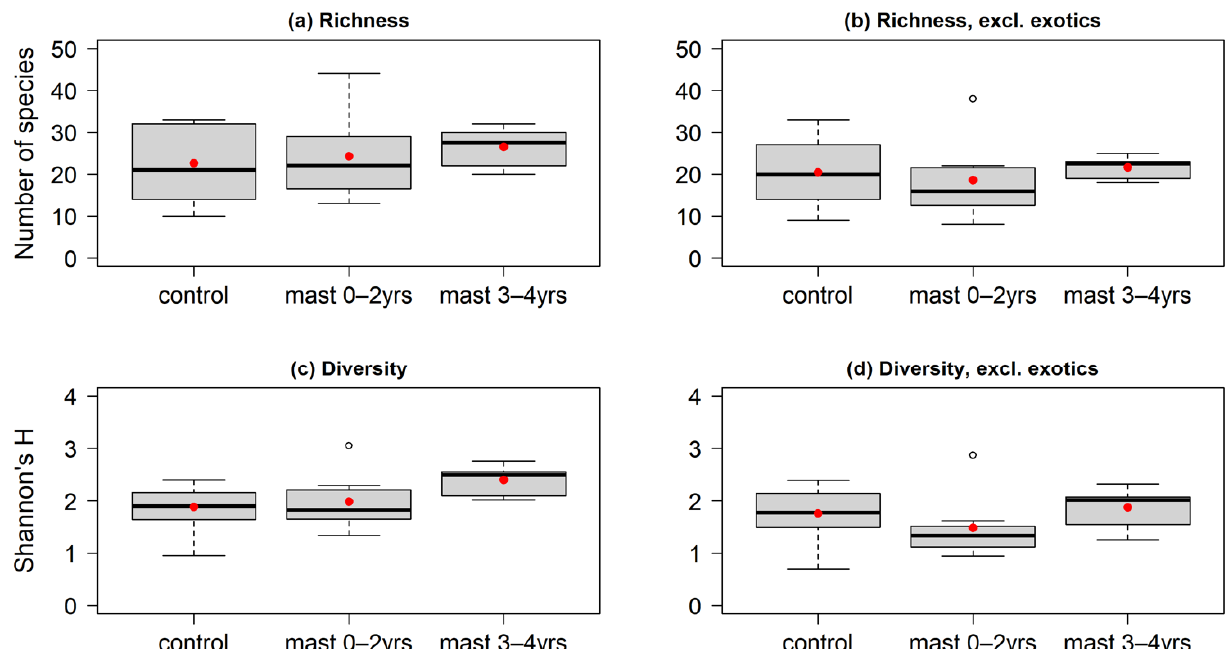
Figure 7. Floristic diversity metrics for ( a ) species richness; ( b ) species richness excluding exotic species; ( c ) Shannon’s H’ and; ( d ) Shannon’s H’ excluding exotic species for 0–2 years since mastication, 3–4 years since mastication and control.